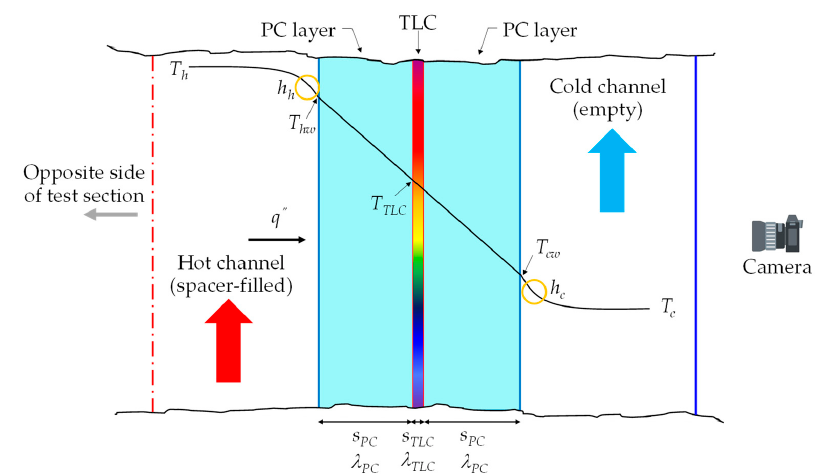
Figure 4. Schematic of heat transfer across the PC-TLC sandwich located on one of the two sides of the test section. T h = bulk temperature of the hot fluid, T c = bulk temperature of the cold fluid, T cw = cold wall temperature, T hw = hot wall temperature, T TLC = TLC temperature, h h = convective heat transfer coefficient on the hot side, h c = convective heat transfer coefficient on the cold side, q ” = heat flux, s PC = thickness of the PC sheet, s TLC = thickness of the TLC foil, λ PC = thermal conductivity of the PC sheet, λ TLC = thermal conductivity of the TLC foil.